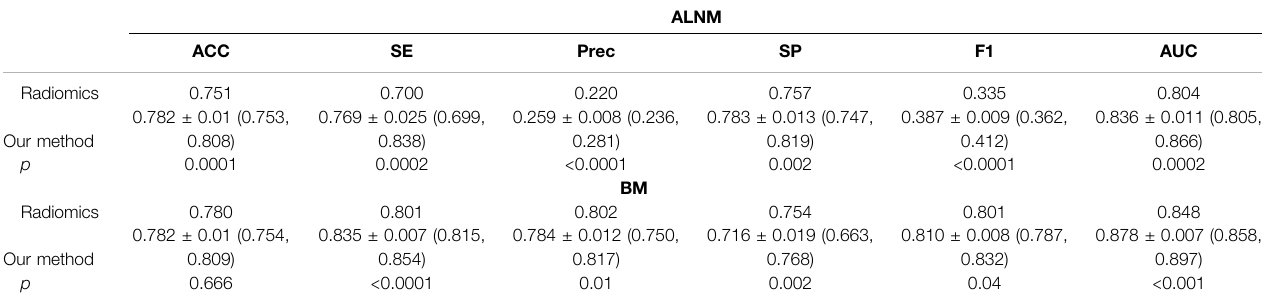
TABLE 2 | Performance of the deep-learning model and radiomics model on the test cohort on ALNM prediction and benign/malignant classi fi cation